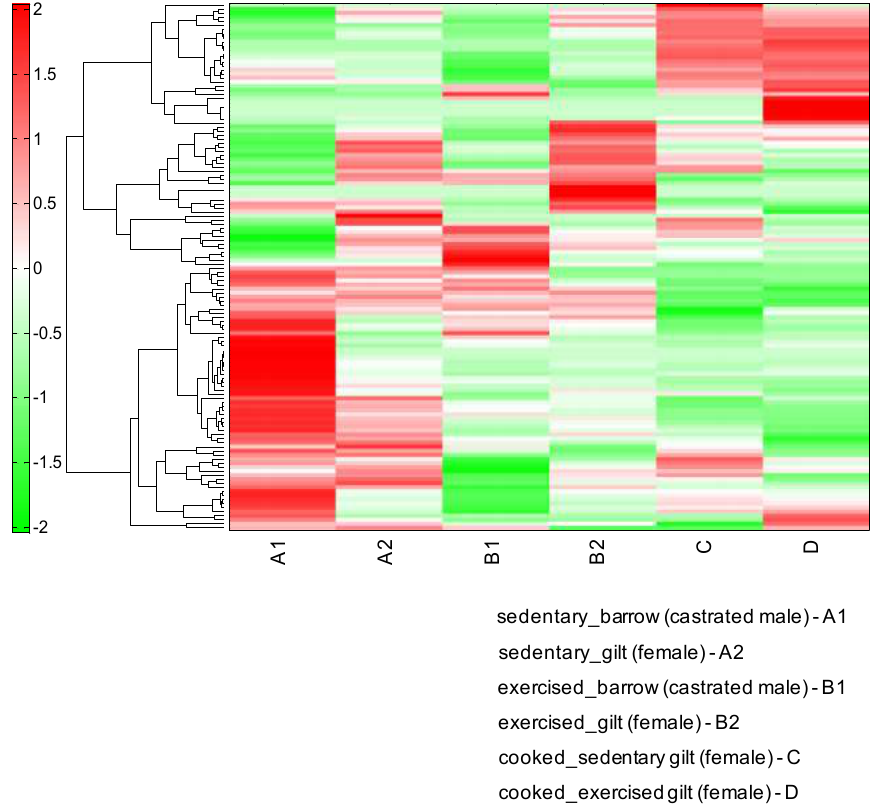
Figure 3. Hierarchical clustering analysis (HCA) of the porcine longissimus dorsi (LD) muscle metabolomic profiles of sedentary or exercising barrows and gilts. We also analyzed cooked gilt LD muscles.